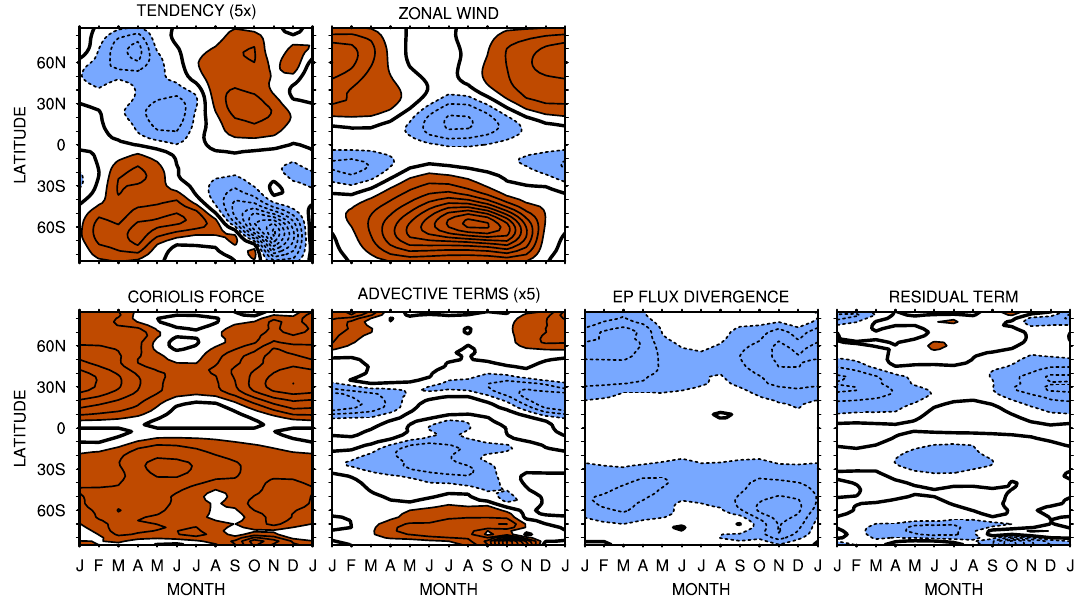
Fig. 1. Annual cycle of the ERA-40 stratospheric zonal-mean zonal wind, zonal wind tendency and each forcing term in the TEM momentum equation averaged between 100 and 20hPa. Dashed (solid) lines and blue (brown) shadings represent negative (positive) values while the bold solid line represent the zero-line. Contour interval is 6ms − 1 for the zonal wind and 0.5ms − 1 day − 1 for the zonal wind tendency and forcing terms. Note that the zonal wind tendency and advective terms are weak compared to the other terms and are therefore multiplied by